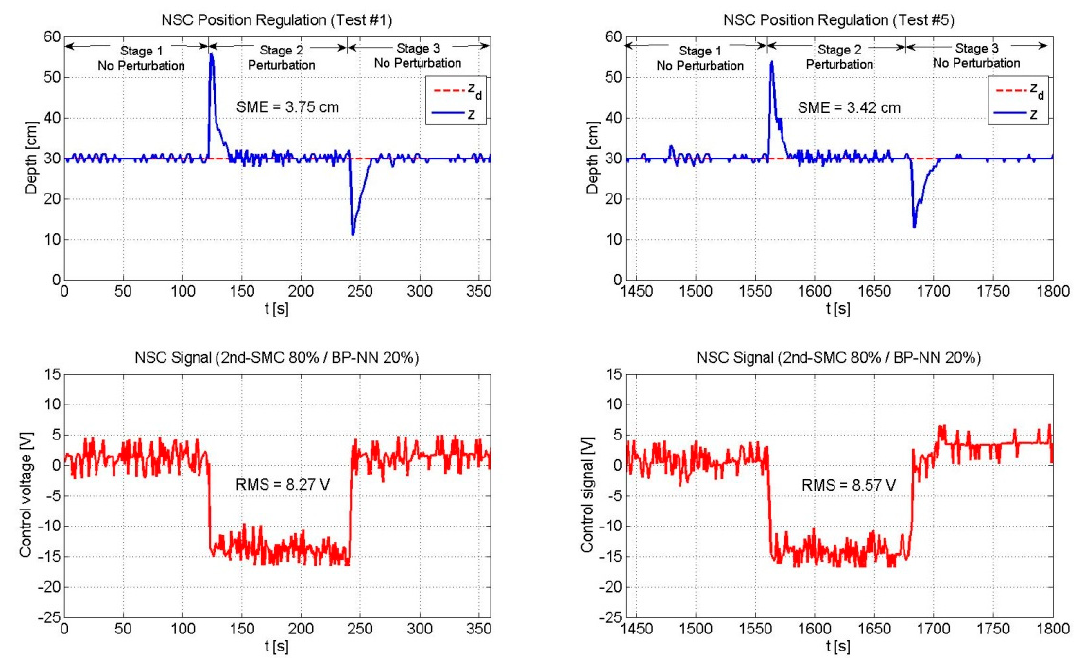
Figure 12. Performance of the NSC scheme (2nd-SMC 80% / BP-NN 20%). The 2nd-SMC scheme was the predominant control with a contribution of 80%. The SME exhibited a reduced value since the beginning; however, due to the low contribution of the BP-NN control, the SME value did not reflect a significant reduction by the end of the experiment. The RMS voltage remained practically unchanged throughout the experiment.